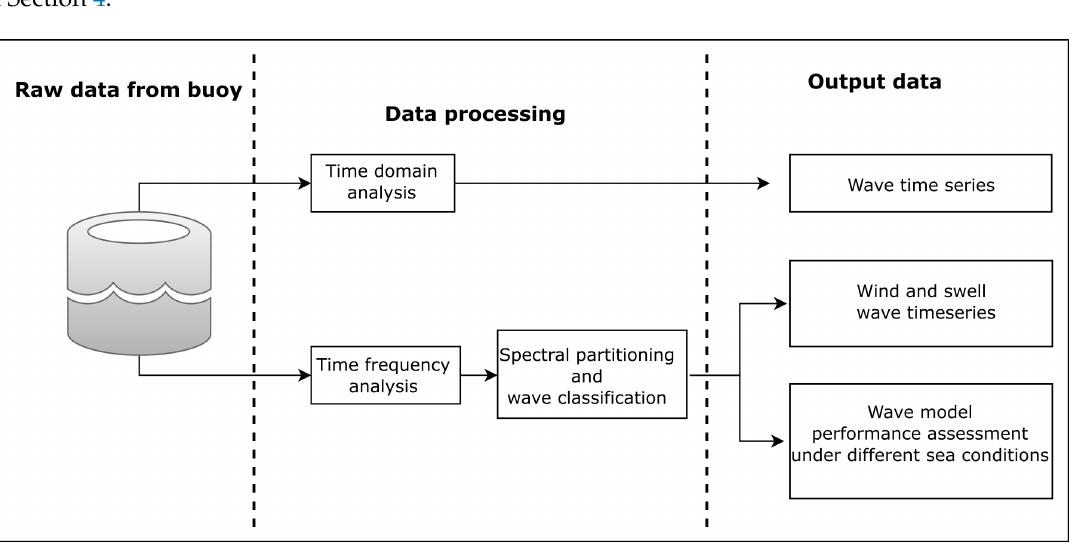
Figure 1. Process flowchart from data acquisition to expected